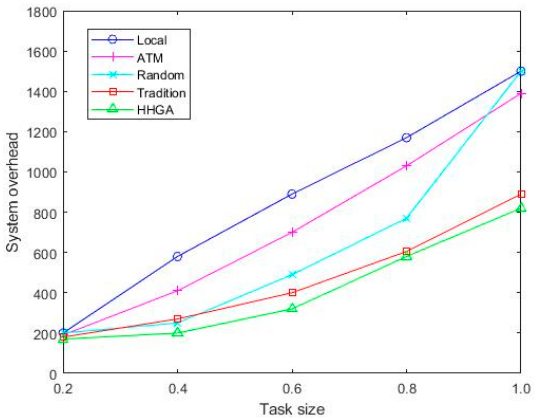
Figure 7. Comparison of system overhead of various algorithms under different task sizes.